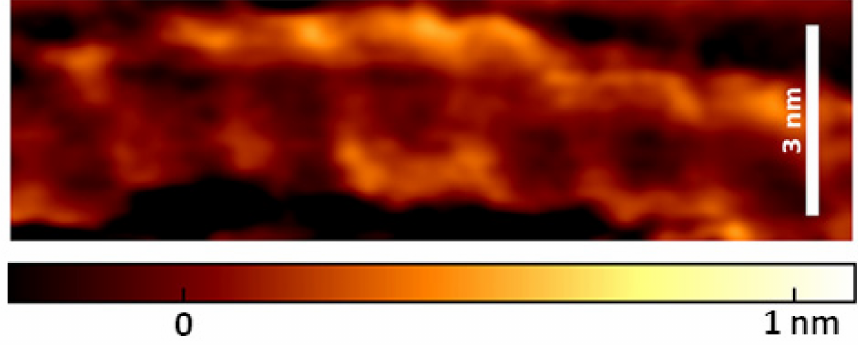
Figure 6. High-resolution AFM image of DNA obtained in tapping mode using a tip with 2 nm of apex radius. Reproduced with permission from Heenan, P.R.; ACS Nano ; published by ACS Publications,